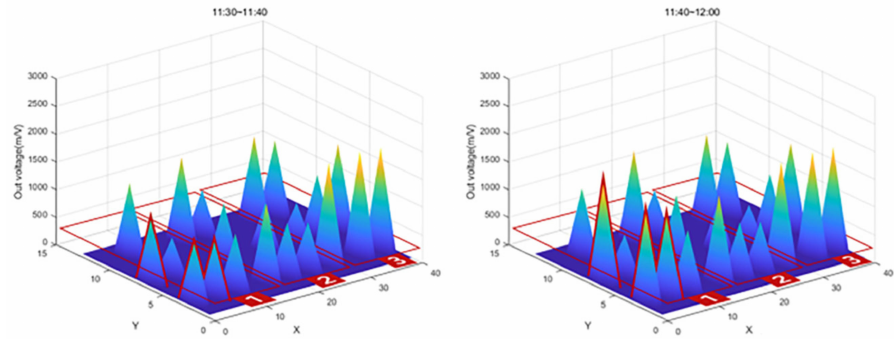
Figure 27. Sum of 3D graph values for data from 11:30–12:00.